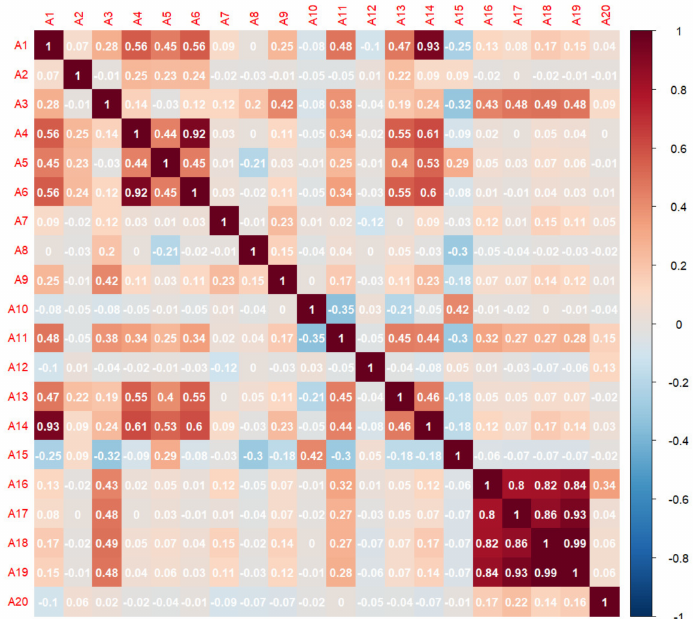
Figure 7. Pearson’s correlation coefficients (PCCs) of the twenty initial conditioning factors. A1: slope;